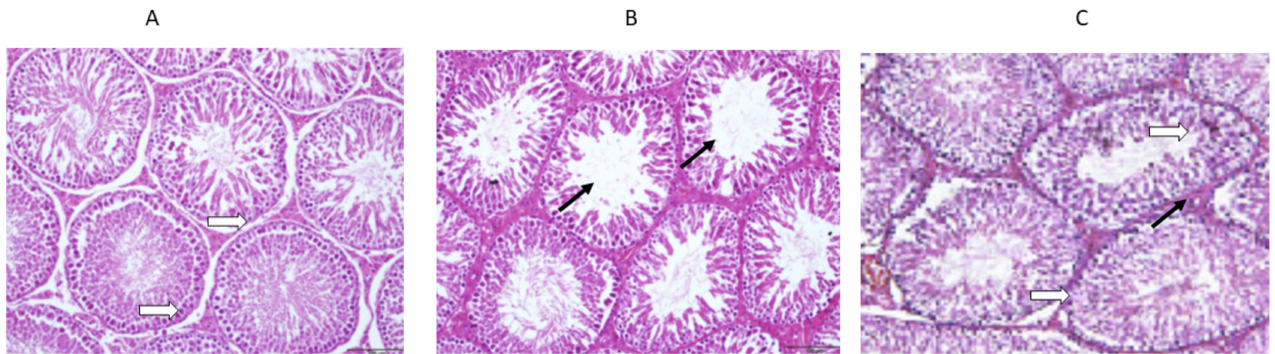
Figure 7. ( A ) The effect of the normal saline administration during the experiment on the histological sections of rat testes was a normal morphology with a normal thickness of the basal lamina (white arrows). ( B ) The effect of the vancomycin administration on the histological sections of rat testes was thinning and splitting of the basal lamina, with atrophy and widely separated seminiferous tubules (black arrows). ( C ) The effect of the resveratrol and vancomycin administration on the histological sections of rat testes was a normal thickness of the basal lamina (white arrows) and normal seminiferous tubules (black